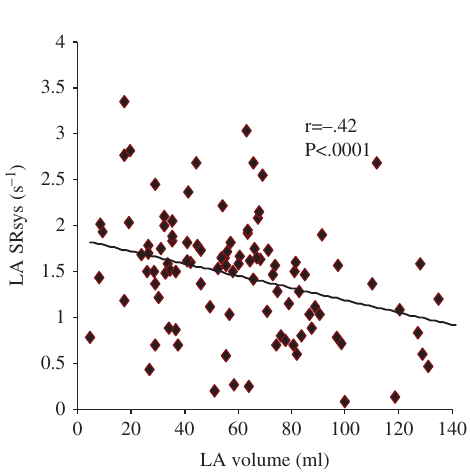
Figure 5. LA systolic SR (SRsys) and LA volume in HCM.